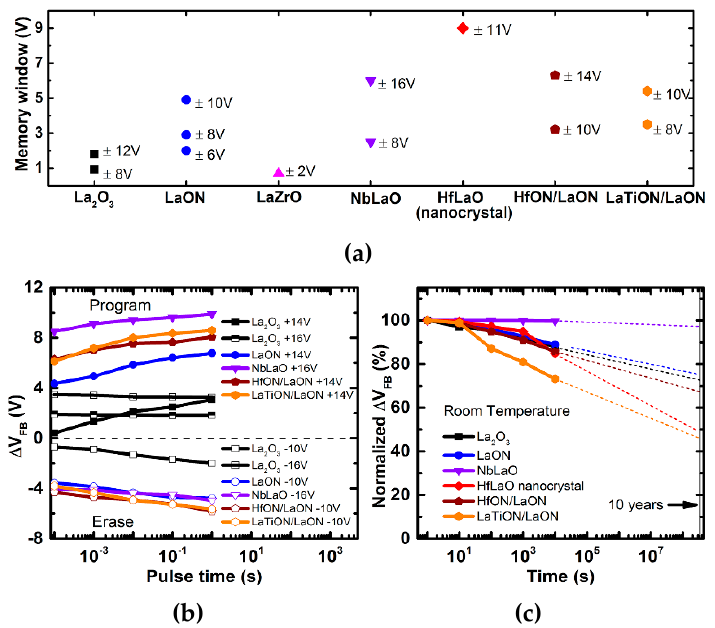
Figure 14. CTM with La-based high-k CTL: ( a ) memory window, ( b ) P/E transient characteristics, and ( c ) retention property